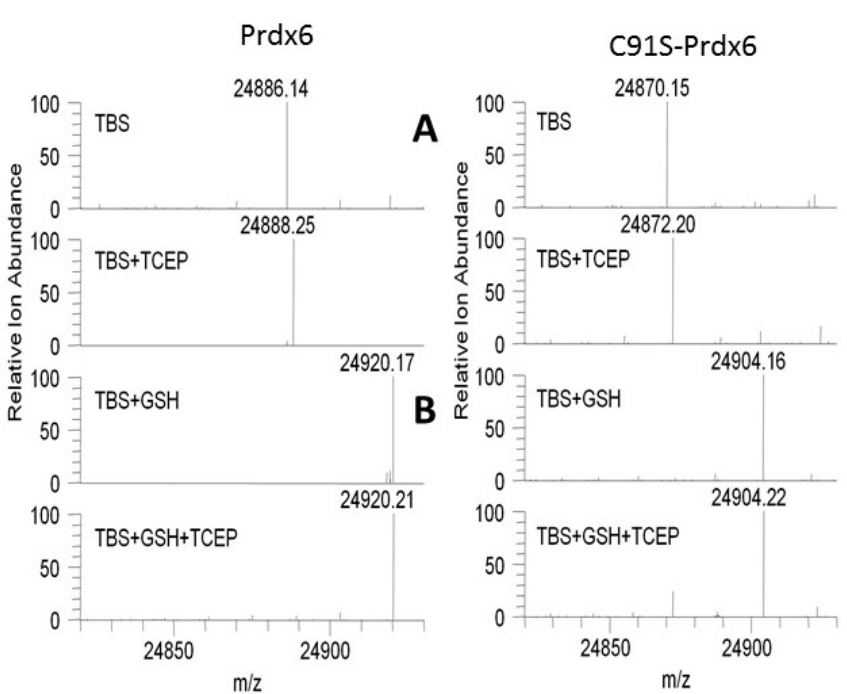
Figure 2. Electrospray ionization mass spectrometry (ESI MS) of wild type and C91S Prdx6. ( A ) upper 4 panels). Effect of tris (2-carboxyethyl) phosphine (TCEP) on protein mass. The addition of TCEP